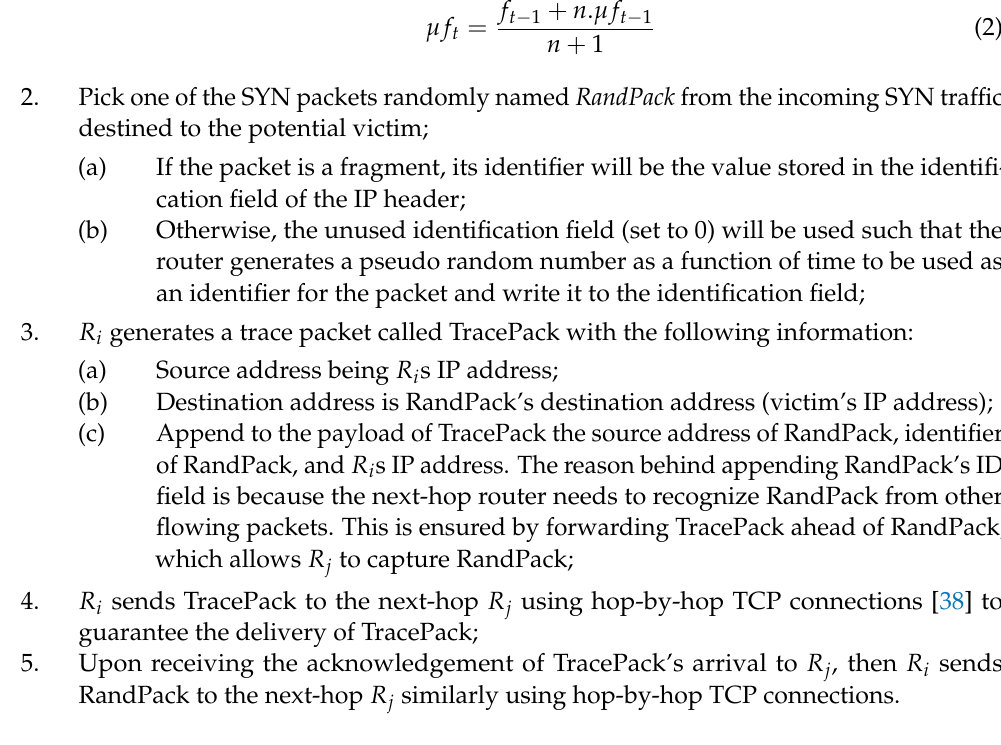
Table 2. Notation used in the RAPT